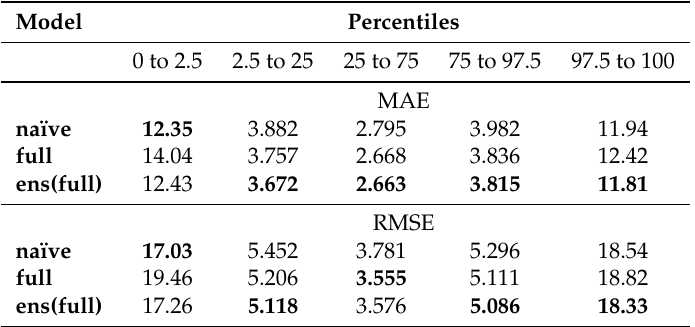
Table 2. The MAE and RMSE errors across five regimes defined by percentiles of the marginal distribution of prices observed in the out-of-sample test period: 0 to 2.5, 2.5 to 25, 25 to 75, 75 to 97.5, and 97.5 to 100. The LASSO model used is the full model with back-transformation (4). The lowest score for each error measure and regime is emphasized in